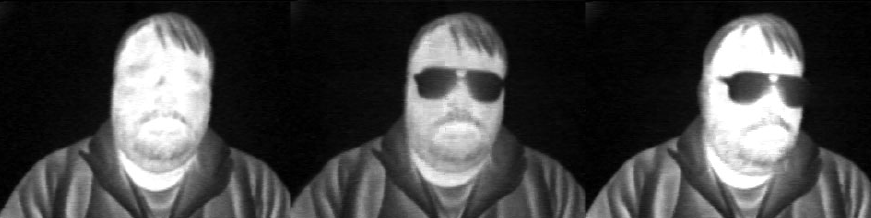
Figure 5. A sample of Terravic dataset